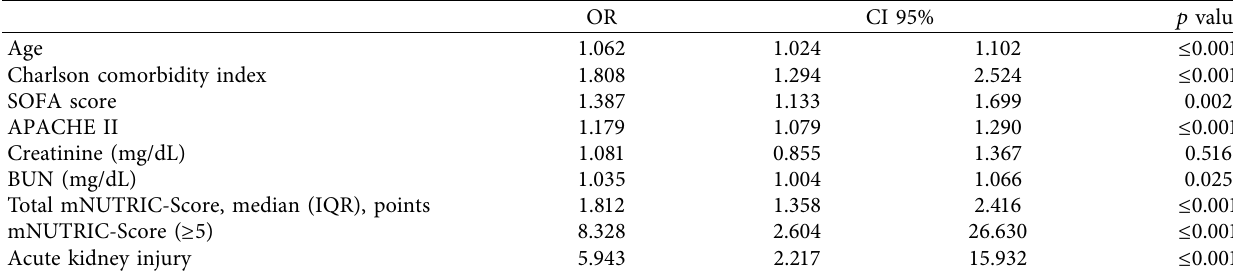
Table 4: Logistic regression of significant variables for 28-day